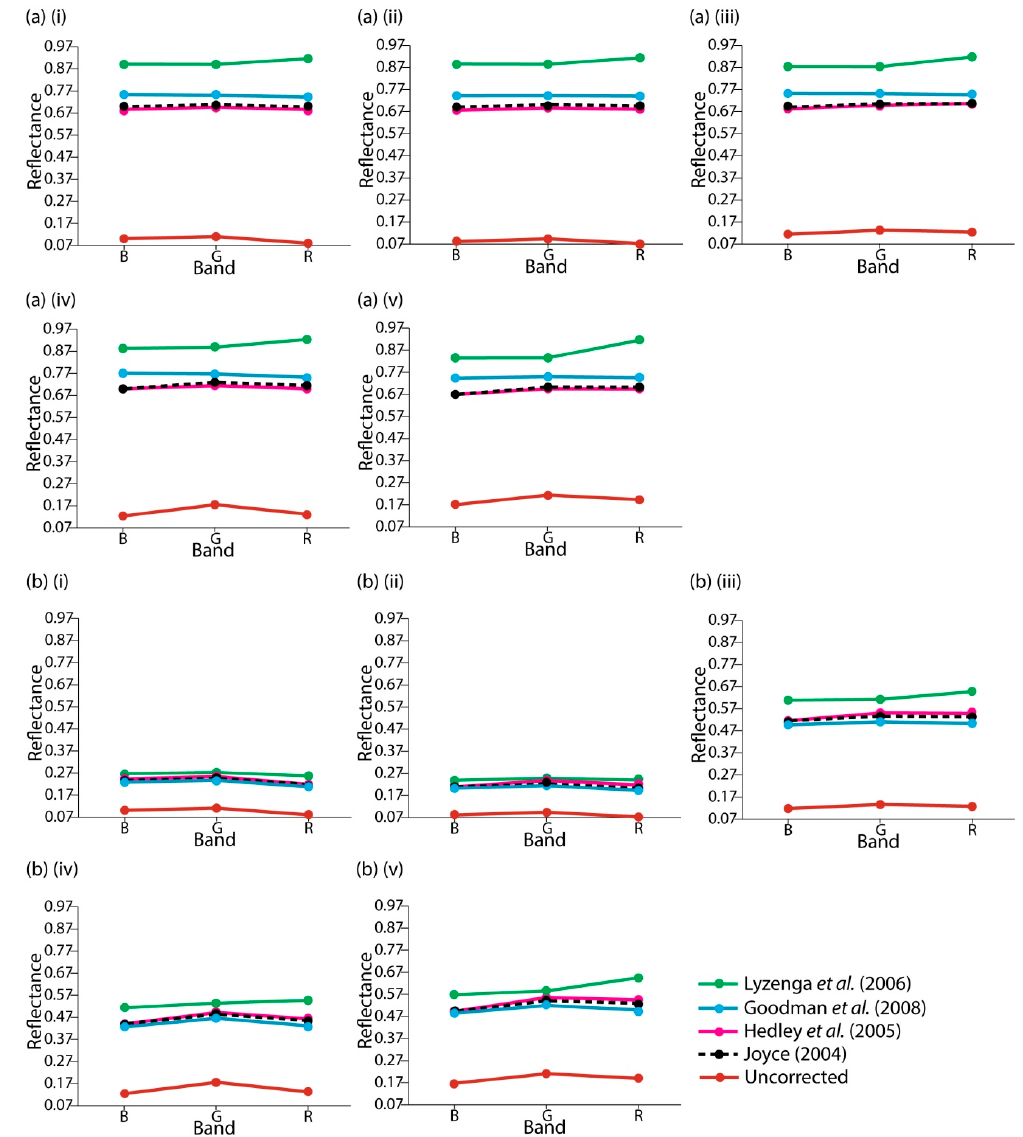
Figure 5. Benthic reflectance spectra of Site-1 (Pantai Pasir Cina) UAV image before (uncorrected) and after glint removal using four different methods proposed by Lyzenga et al. [35], Goodman et al. [29], Hedley et al. [28], and Joyce [47], following two strategies: ( a ) Strategy-1 and ( b ) Strategy-2. The benthic spectra were collected from an area with a water depth of approximately − 1.5 m, present in the reflectance graphs shown for ( i ) branching coral— Acropora (BC), ( ii ) tabulate coral— Acropora + Montipora (TC), ( iii ) patch coral (PC), ( iv ) coral rubble (R), and ( v ) sand (S).